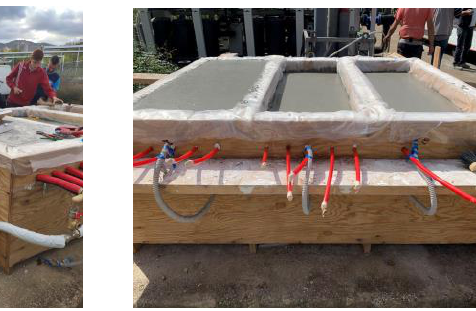
Figure 5. Some phases of the installation of the RTC Box.